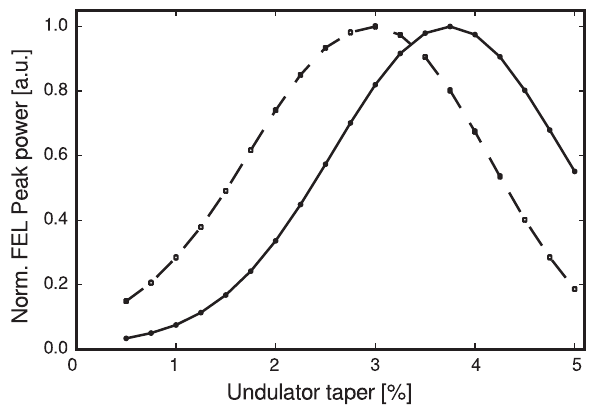
FIG. 17. FEL peak power versus undulator tapering using (dotted line) real and (dash squared line) ideal undulator magnetic field. Beam transport in the nonlinear case with OCELOT using the S2I-CM optics with r 11 ¼ r 33 ¼ 10 and r 56 ¼ 0 . 4 mm. FEL simulation with